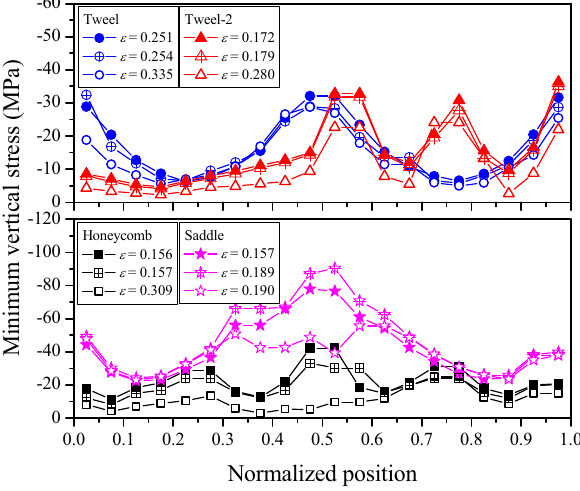
Figure 13: Radial distribution curves of the maximum compressive stress of spoke No.